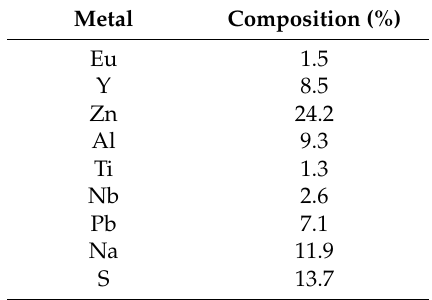
Table 1. Elemental chemical composition of coating powder with an X-ray analyzer in